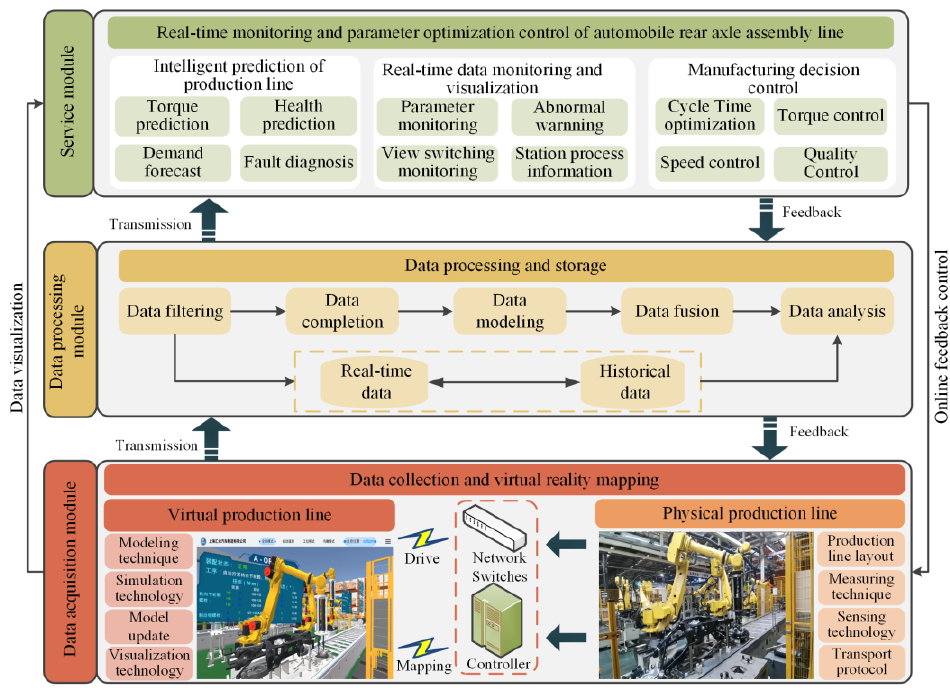
Figure 1. Overall architecture of the rear axle assembly line digital twin system.